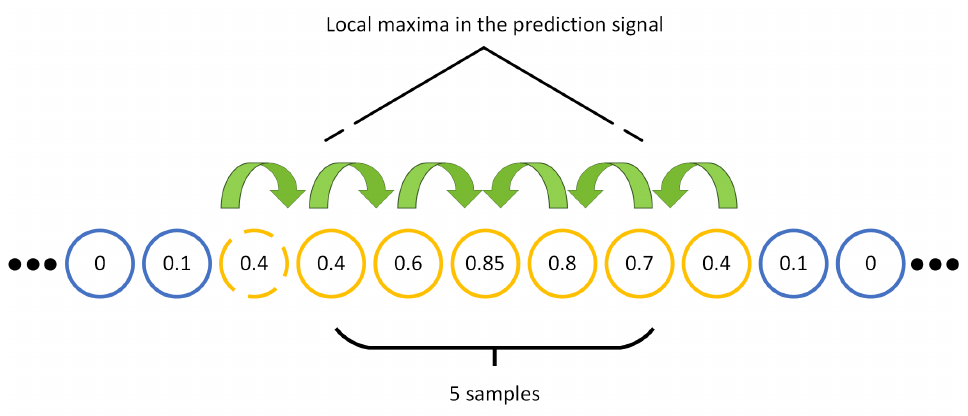
Figure 9. The procedure of selecting predictions that are above the given